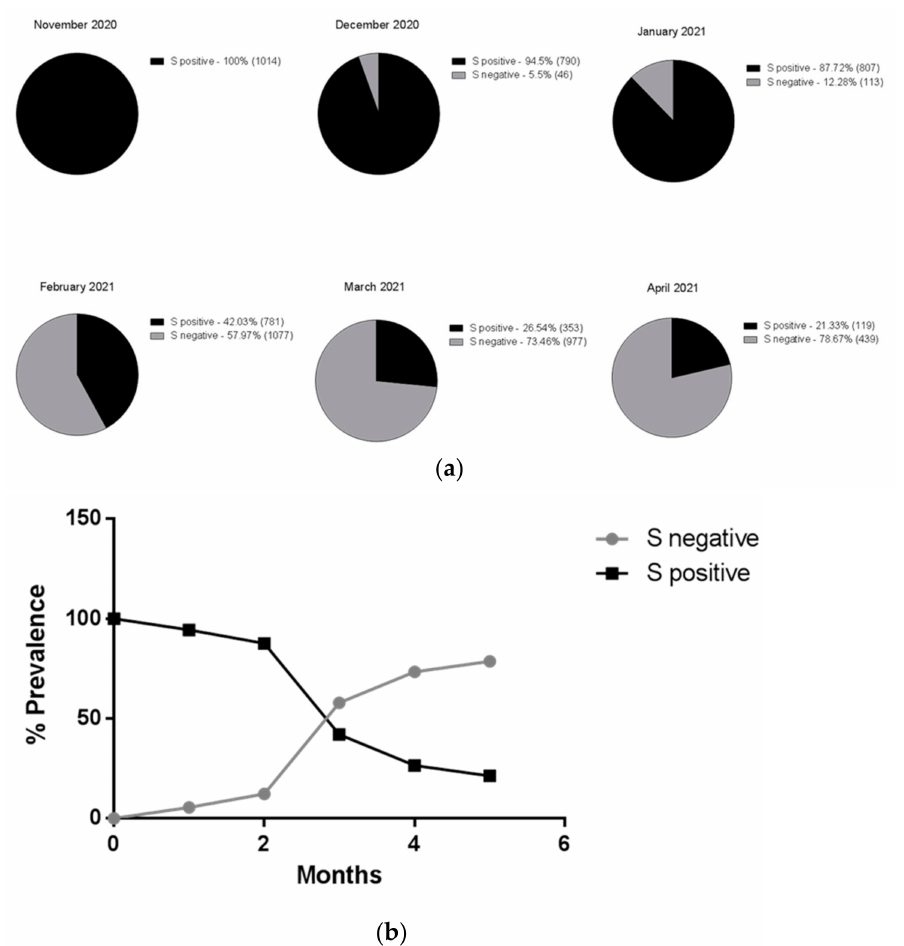
Figure 3. Time course of the number of positive cases with three genes amplified (black) and with two genes (grey), shown as ( a ) pie chart (absolute frequency percentage) or ( b ) line graph (prevalence